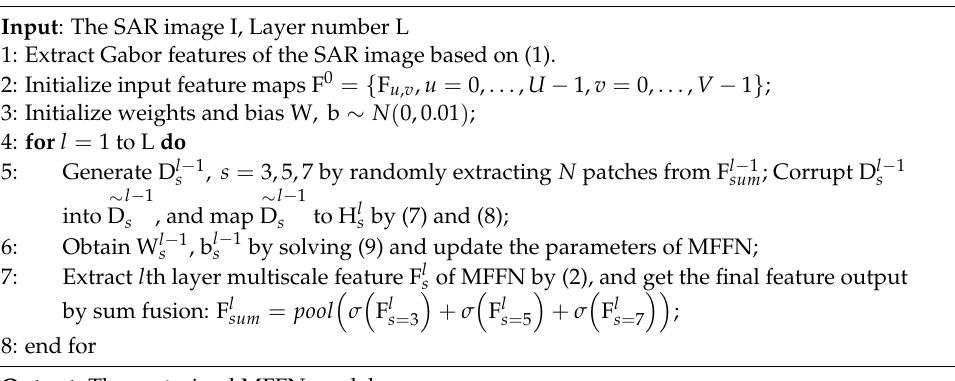
Algorithm 1 Gabor filtering-based multiscale unsupervised deep fusion feature